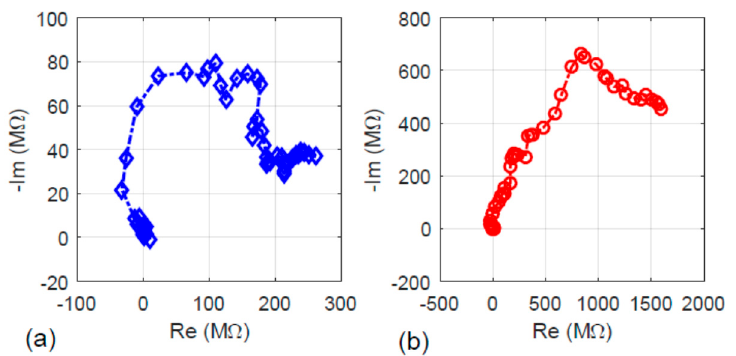
Figure 6. The real part (Re) versus the imaginary part (Im) of the specimens’ impedance: ( a ) without hydrothermal carbonization treatment and ( b ) with hydrothermal carbonization treatment.